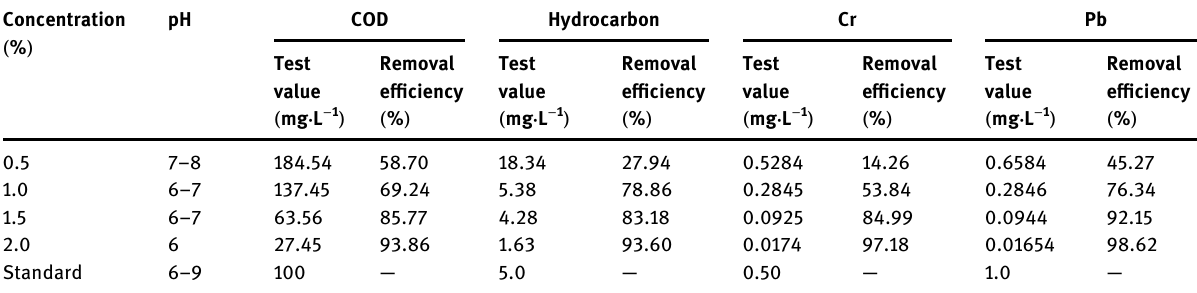
Table 4: Treatment e ff ect of RH - β - CD waste water - based drilling fl uid fi ltrate pollutants Concentration ( % )